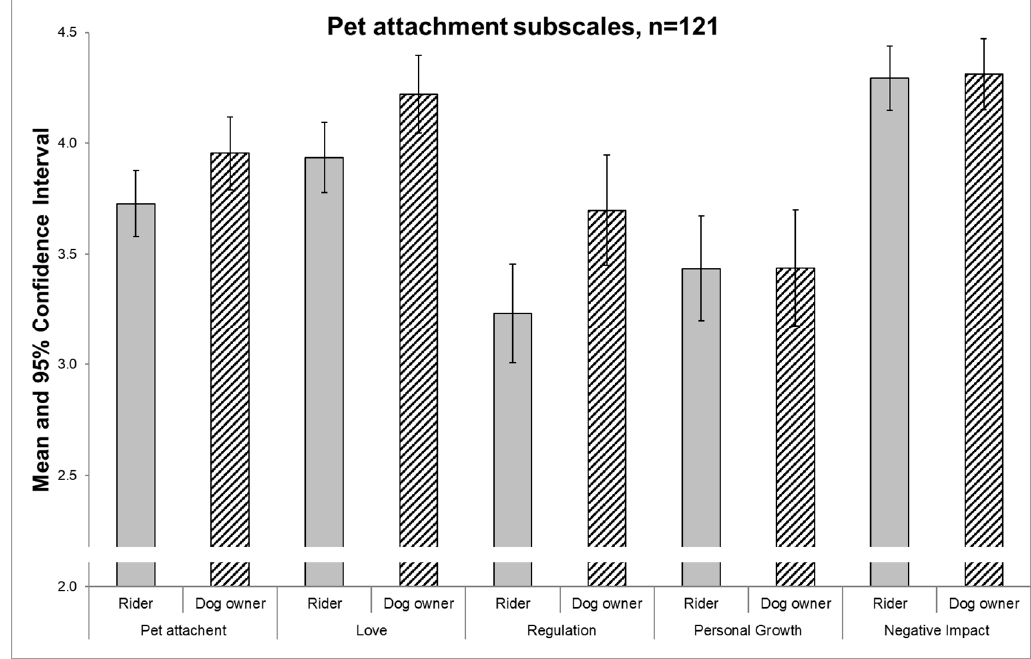
Figure 1. Pet attachment and subscales scores (mean and 95% confidence intervals) in riders and dog owners .